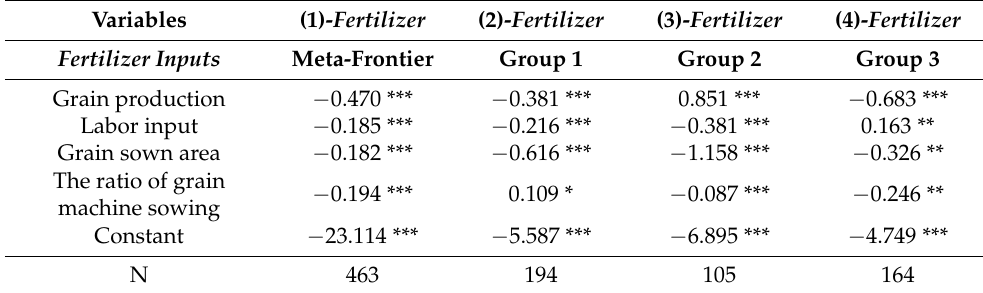
Table 2. Estimation results of the meta-frontier and the groups’ frontier.